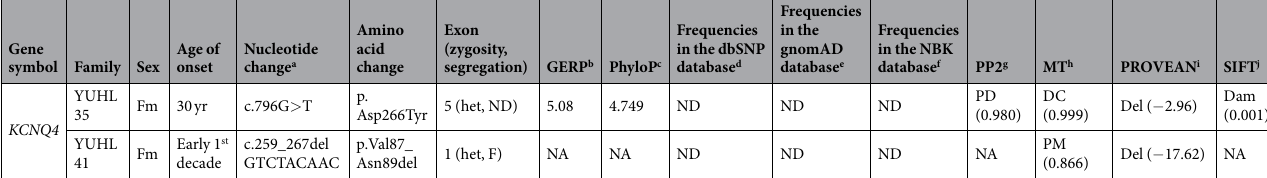
Effects of the identified mutations on the surface expression and subunit interactions of KCNQ4. To evaluate the impact of the identified mutations on trafficking of KCNQ4 to the plasma membrane, we performed surface biotinylation of WT and mutant KCNQ4 proteins in HEK293 cells. When overexpressed, both mutant proteins and the WT protein showed cell surface expression (Fig. 2a). The absence of the cytosolic protein aldolase A in the biotinylated fraction confirmed cell surface protein-specific labeling. In addition, there were no differences in expression levels between WT and mutant proteins. Immunofluorescence analysis showed that both mutant proteins and the WT protein were localized to the plasma membrane (Figs 2b and S3). p.Val87_Asn89del mutant protein reached the cell surface, although a signifi- cant portion of the protein seemed to be trapped in the endoplasmic reticulum (ER) or Golgi apparatus, as shown by colocalization with the ER marker Calnexin and Golgi marker Giantin, respectively (Fig. 2b). The Val-Tyr-Asn residues at positions 87–89 of KCNQ4 are also conserved in KCNQ1 and these amino acid residues are a part of the N-terminal juxtamembranous domain which is critical for surface expression of KCNQ1 13 . Therefore, we compared p.Val87_Asn89 mutant protein with a known trafficking mutant ( Δ F508) of cystic fibrosis transmem- brane conductance regulator (CFTR) 14 . The expression level of Δ F508-CFTR was significantly increased by the proteosomal inhibitor MG132, whereas those of WT-CFTR, WT and mutant KCNQ4 proteins were not affected by MG132 (Fig. S4). The amount of p.Val_Asn89del mutant protein was not changed by the lysosomal inhibitor leupeptin (Fig. S4a). The functional potassium channel is formed by a tetrameric assembly of KCNQ4 subunits 9 . Individuals with KCNQ4 mutations were heterozygous (Fig. S2), and expression levels of mutant proteins were comparable to that of the WT protein (Fig. 2a). Therefore, WT or mutant Myc-tagged KCNQ4 clones were cotransfected with the WT FLAG-KCNQ4 clone into HEK293T cells. The heteromeric assembly was analyzed by co-immunoprecipitation. Similar to WT protein, both p.Val87_Asn89del and p.Asp266Tyr proteins showed normal ability to interact with WT protein, suggesting that tetramerization between WT and mutant proteins was unlikely to be disrupted (Fig. 2c,d). Effects of the identified mutations on KCNQ4 channel conductance. Ion conductance of homomeric mutant channels was compared with that of the functional WT KCNQ4 channel. In conventional whole-cell patch clamp recordings, KCNQ4 mutant channels could not generate appreciable K + currents (Fig. 3). After subtraction of the linopirdine-sensitive component from the total K + current, the I-V curve of the WT KCNQ4-mediated K + current showed a typical curve of KCNQ4 channels (Fig. 3a,b). However, similar to GFP-transfected cells, p.Asp266Tyr and p.Val87_Asn89del mutant channels produced barely detectable currents (Fig. 3c). Furthermore, these two mutant channels were not activated by known KCNQ openers (10 μ M retiga- bine, 3 μ M ML213, and 10 μ M zinc pyrithione) 15–18 . Combination of retigabine or ML213 with zinc pyrithione further increased WT-mediated current in an additive manner. However, none of the combinations activated the current in either mutant (Fig. 3d–g). These findings suggest that both p.Asp266Tyr and p.Val87_Asn89del channels were loss-of-function mutants.